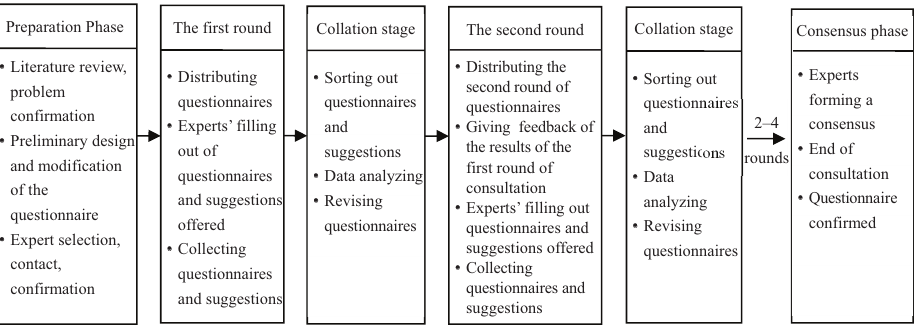
Figure 2. The key process of Delphi survey (source: Hasson et al., 2000; Shariff, 2015; Haven et al., 2020,